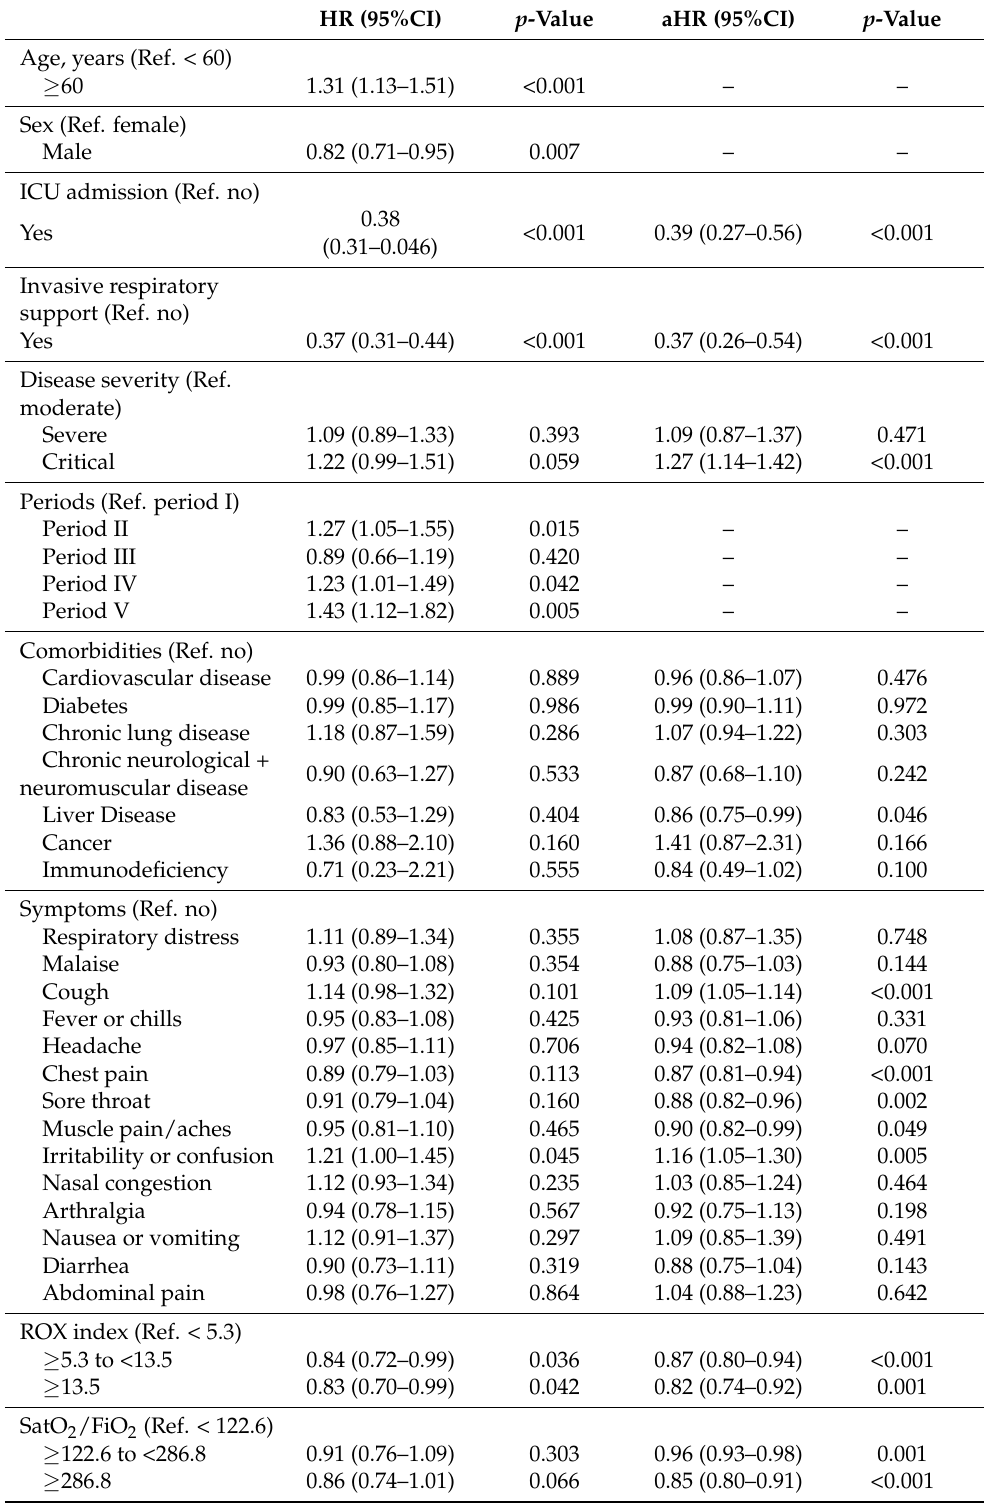
Table 4. Risk factors and hazard ratios of dying from